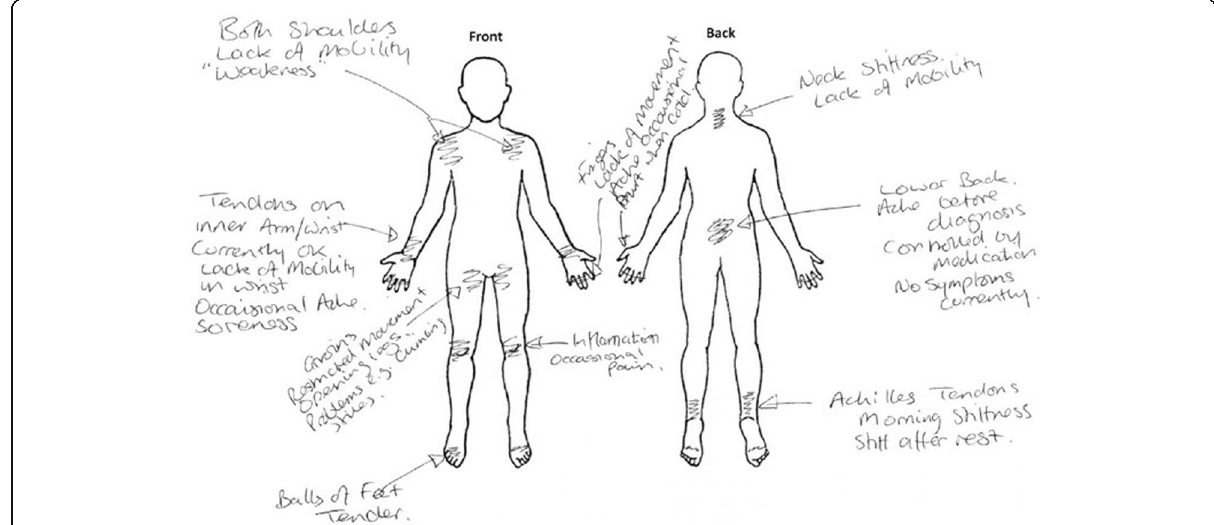
Fig. 3 Body mapping exercise as completed by